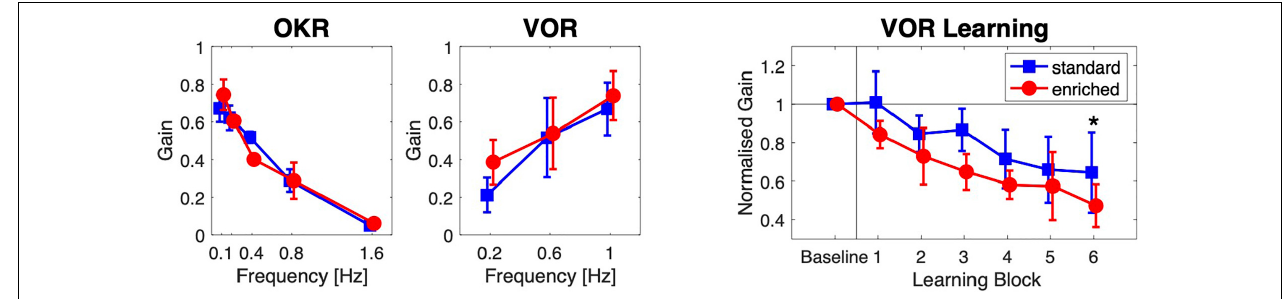
FIGURE 4 | Oculomotor learning. Optokinetic (OKR) and vestibular (VOR) compensatory eye movements, and VOR Learning for the two groups of mice. The OKR and VOR gain are plotted against the stimulation frequency. The mean normalized VOR gain is plotted against Learning Block. Error bars indicate standard deviations (* = post hoc significance p <